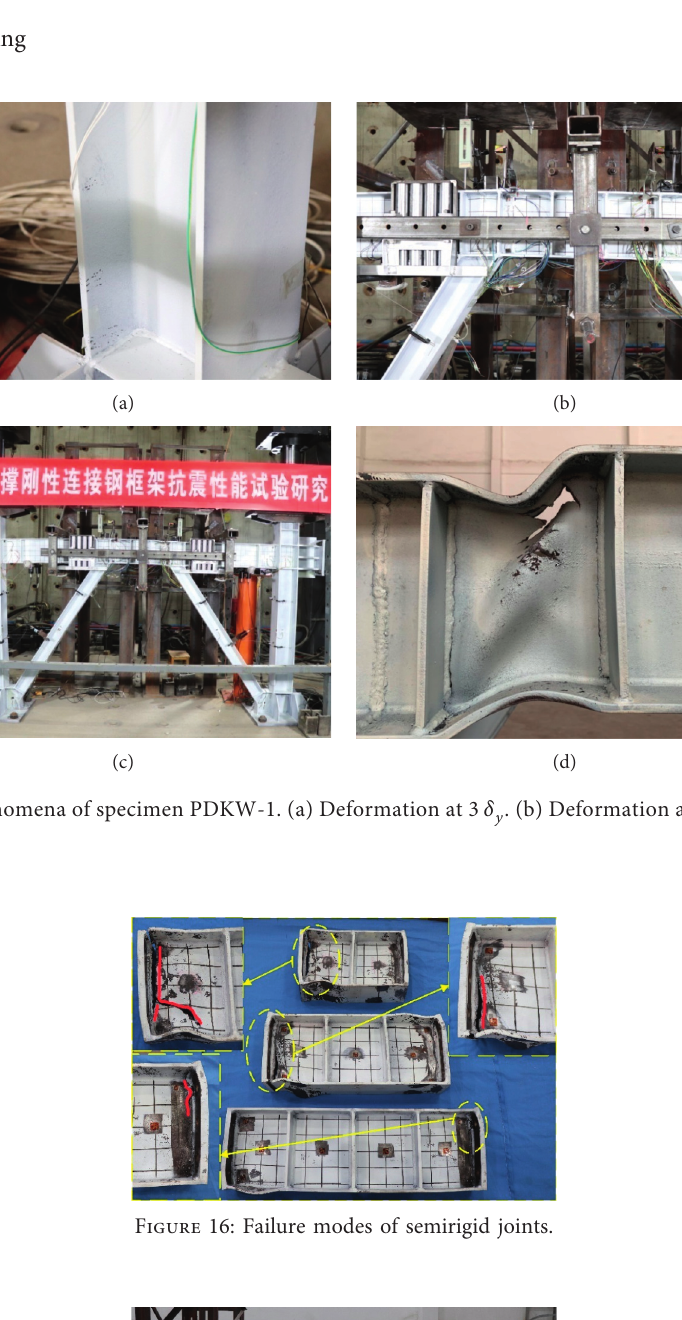
Figure 16: Failure modes of semirigid joints.